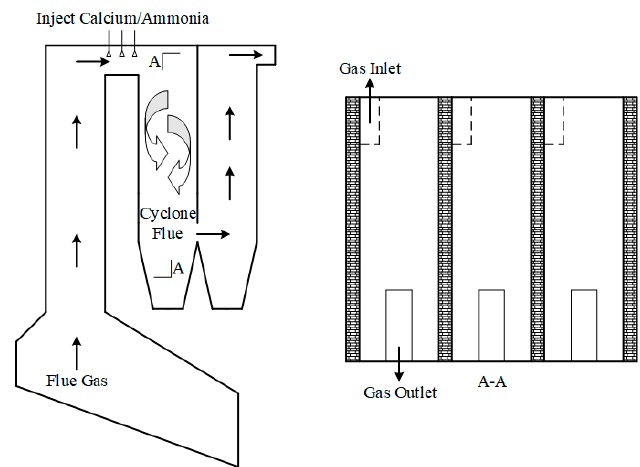
Figure 1. Arrangement diagram of cyclone flue in grate waste incinerator.